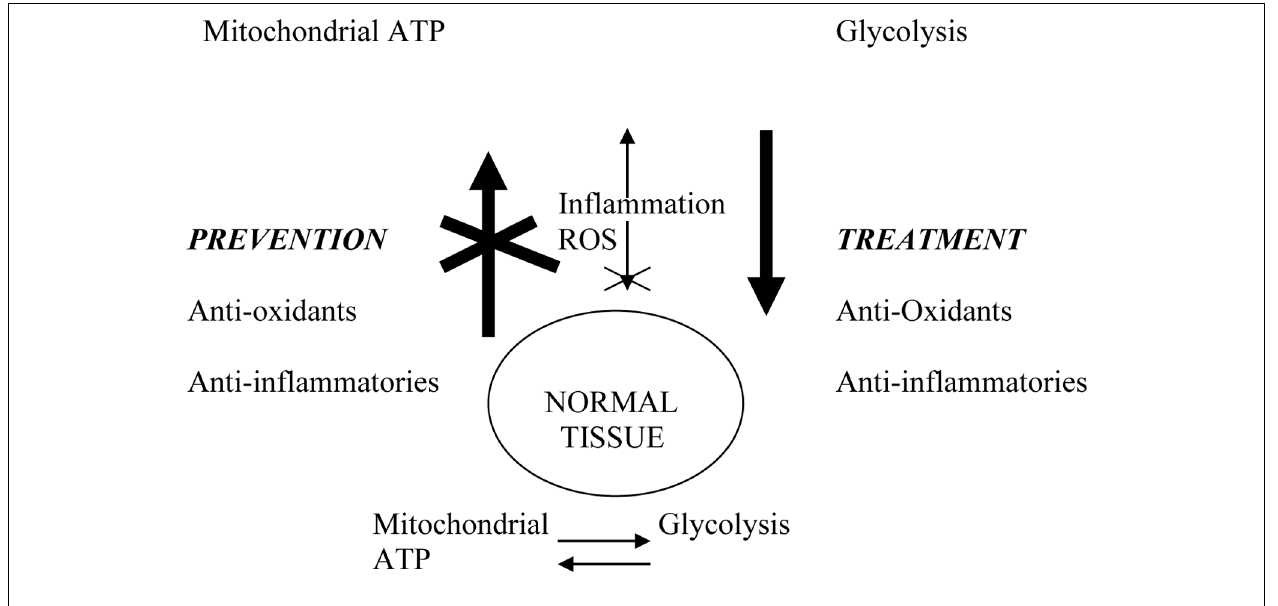
FIGURE 8 | Physiological connections that may link cancer prevention and treatment. Excessive ROS (reactive oxygen species) due to aging or environmental exposure damage mitochondria and promote glycolytic switch characteristic of tumor cells. Inflammation and ROS activate NF-kB and other transcription factors that drive tumor progression. Anti-inflammatory agents